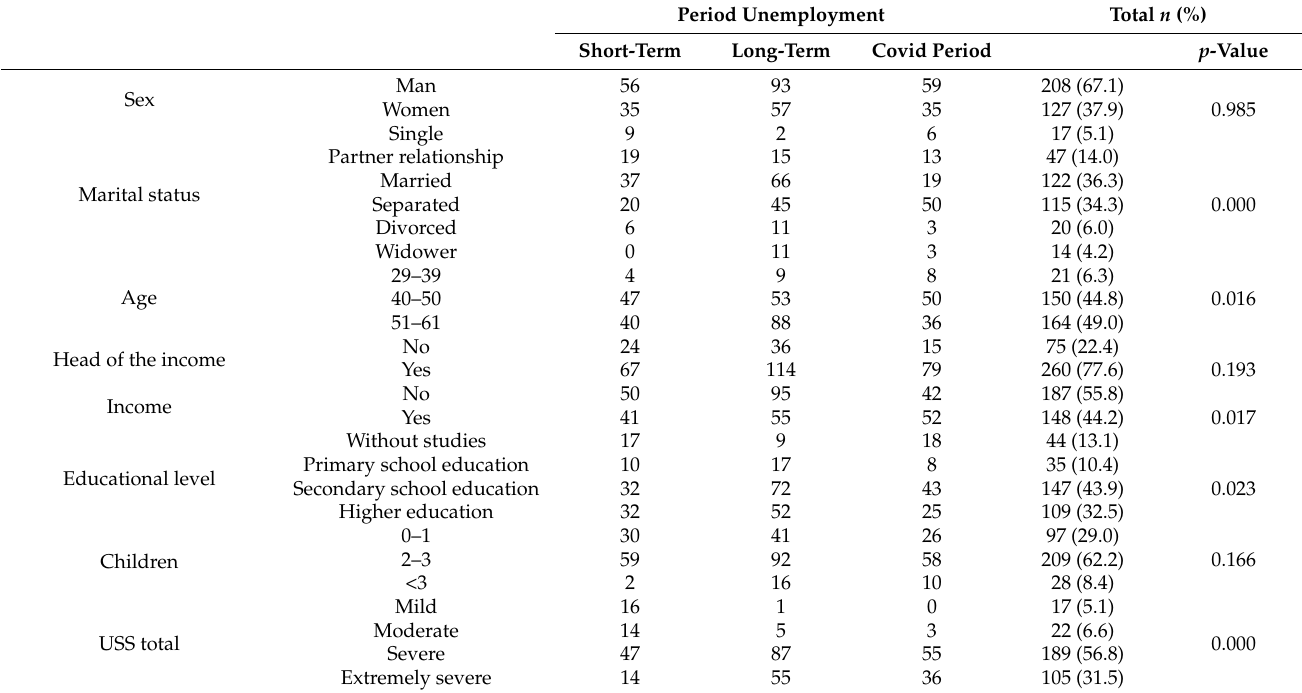
Table 1. Characteristics of the sample and descriptive statistics by employment